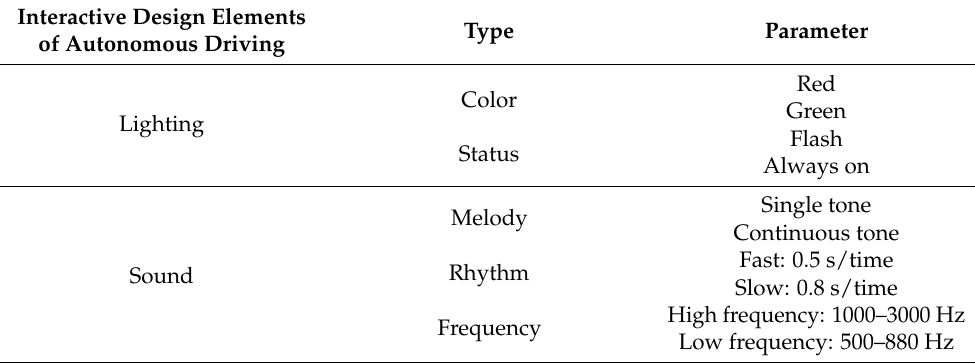
Table 1. Combinations of sound and visual variables. Interactive Design